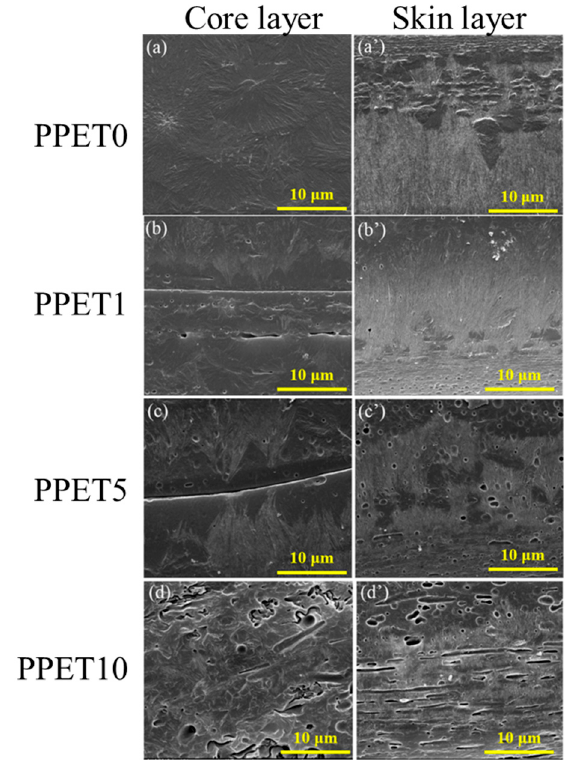
Figure 8. SEM images of M-parts. The mold temperature is 120 °C.